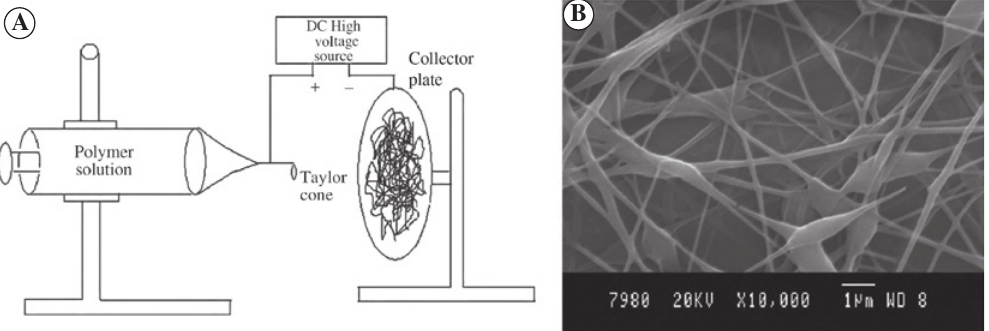
Figure 2: (A) Production of CuO-ZnO nanocomposite by sol-gel and electrospinning methods. (B) SEM image of CuO-ZnO nanocomposite. Copyrights reserved to Elsevier